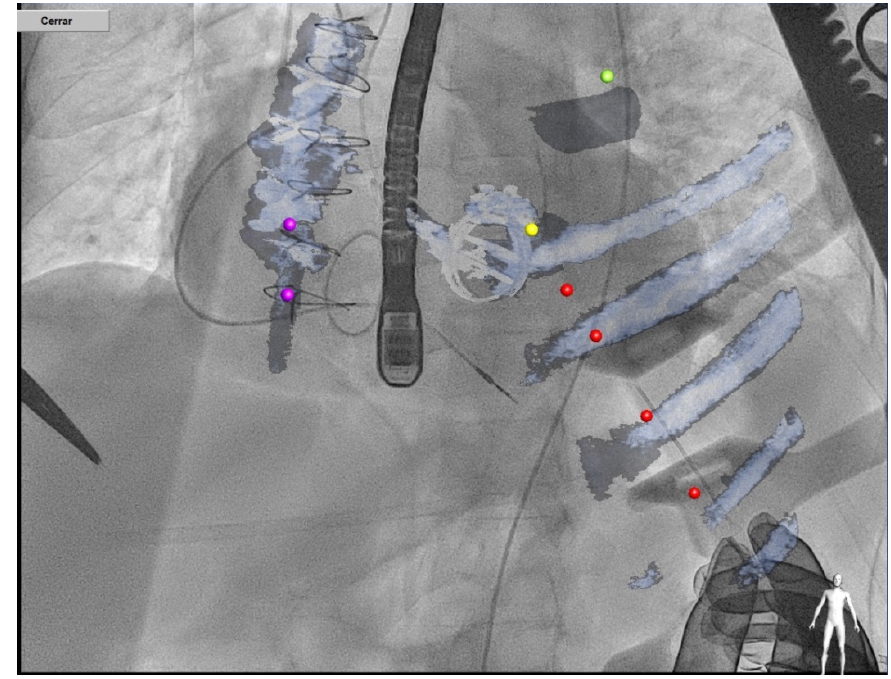
Figure 10. Transapical approach using CT–fluoroscopy